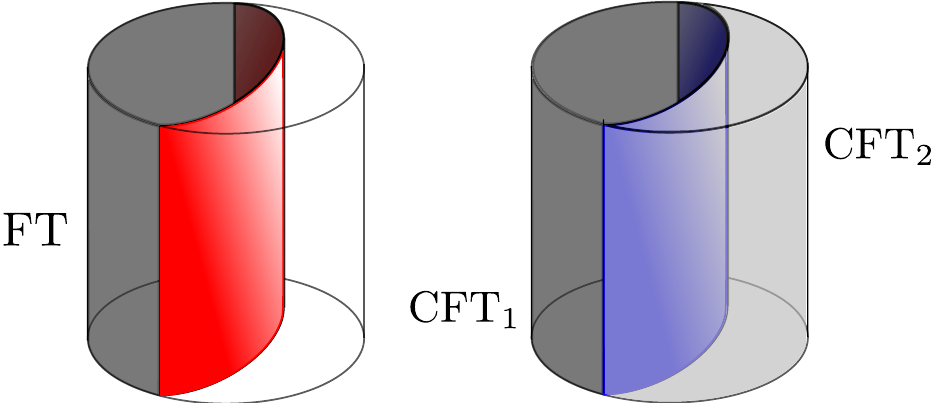
Figure 4 . Holographic duals of (left) boundary CFT and (right) interface CFT. The ETW brane is illustrated in red, and the interface brane in blue. We can interpret these diagrams as either representing Euclidean spacetimes, or the Lorentzian spacetimes obtained by Wick rotating a coordinate of one of the transverse directions suppressed in figures 1, 2, and 3, which is the vertical direction here. In Lorentzian signature, the intrinsic geometry of the ETW/interface brane is a traversable asymptotically AdS